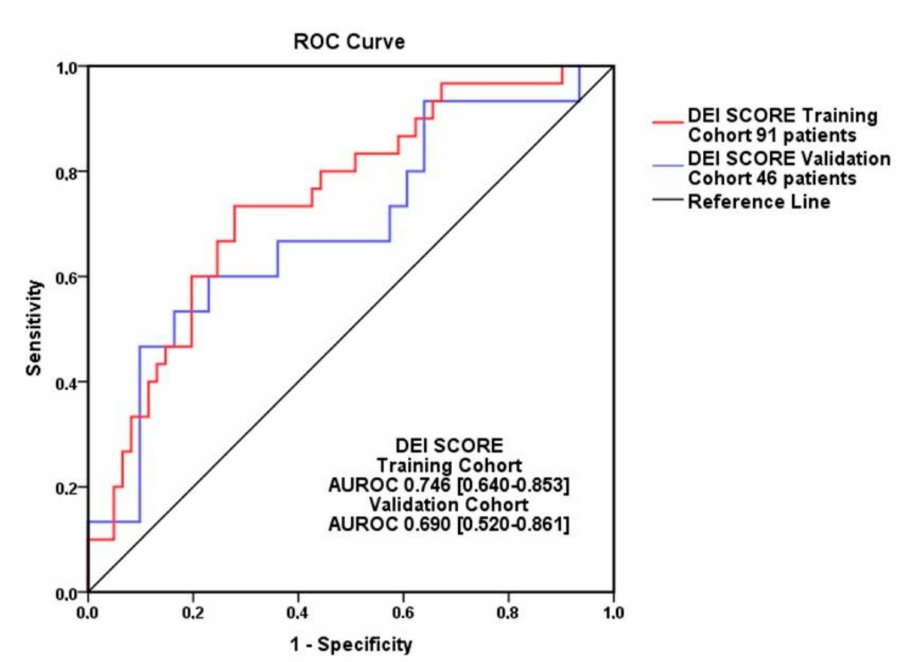
Figure 6. ROC curves of the training cohort (91 patients-red) and validation cohort (46 patients-blue). The two AUROC show close values and no significant differences (Hanley & McNeil test, p = 0.47). We performed an analysis of the DEI Score in the training cohort based on its cut-off values in terms of maximizing sensitivity, specificity, or according to the Youden’s Index criteria, and the result is reported in Table A5: (A) a DEI Score ≤ − 2.605 showed a 100% sensitivity, 9.84% specificity, 5.5% PPV, 100% NVP, 1.11 +LR; (B) a DEI Score ≥ − 0.747 showed a 73.33% sensitivity, 72.13% specificity, 12.2% PPV, 98.1% NVP, 2.63 +LR, 0.37 − LR; (C) a DEI Score ≥ 0.812 showed a 10% sensitivity, 100% specificity, 100% PPV, 95.6% NVP, 0.90 −